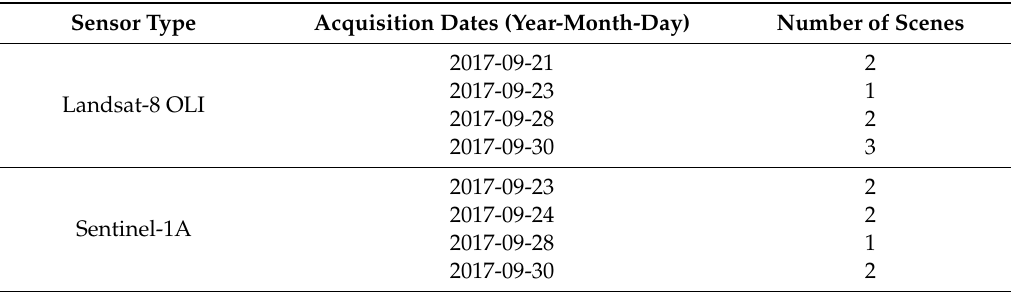
Table 1. Details of Landsat-8 and Sentinel-1A satellites